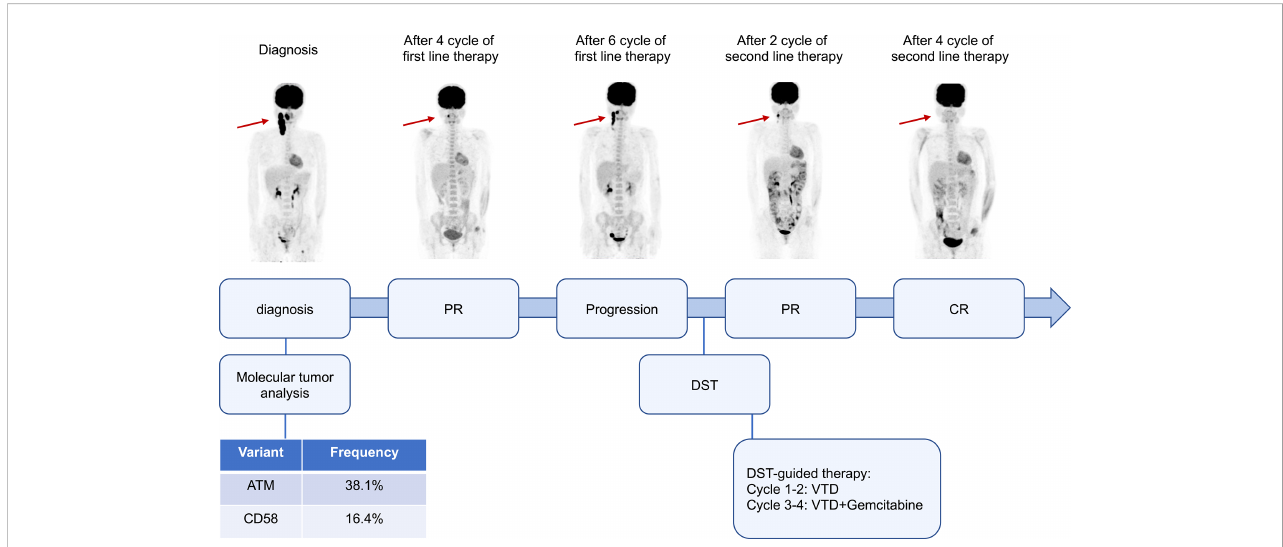
FIGURE 1 Clinical course and response images of the patient. PR, partial response; CR, complete response; DST, drug sensitivity test; VTD, bortezomib, thalidomide, and